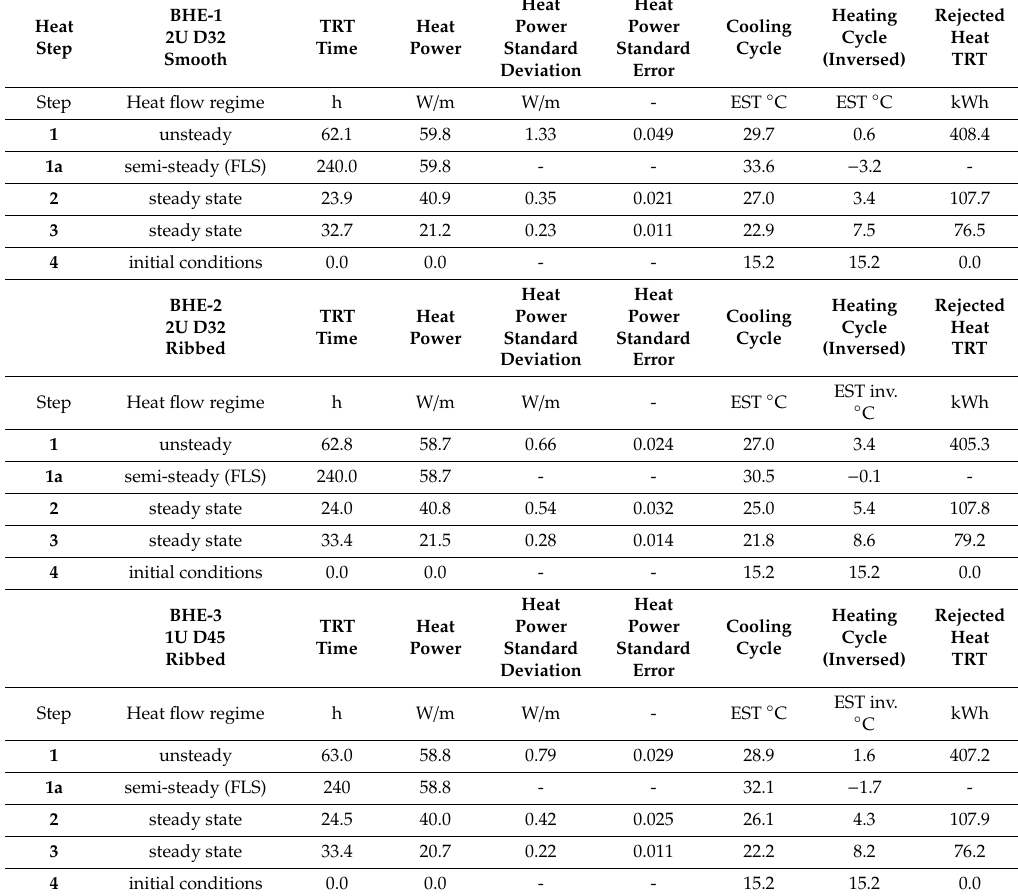
Table 1. Thermal Response Step Test obtained temperature data.